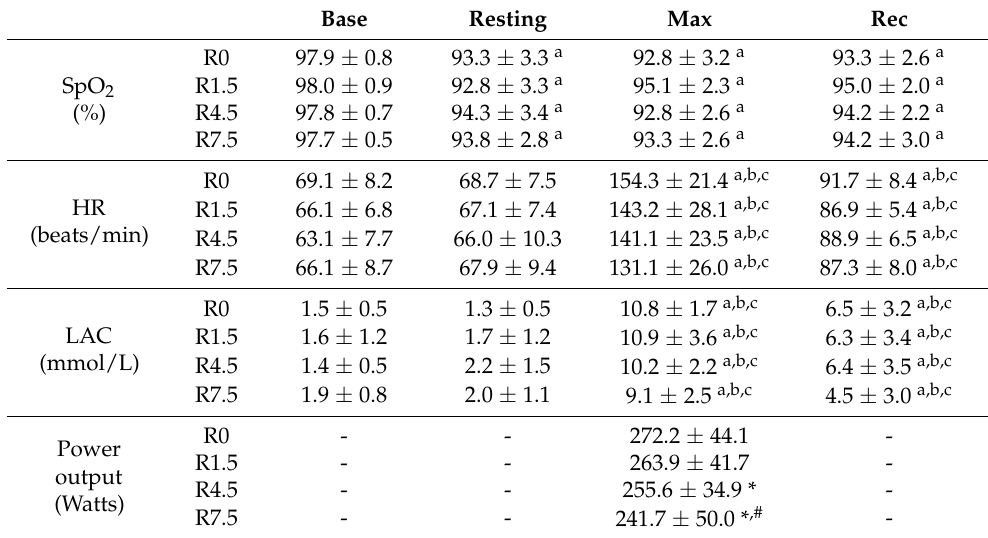
Table 1. Peripheral oxygen saturation (SpO 2 ), heart rate (HR), lactate (LAC), and power output during baseline, resting, maximal exercise, and recovery at four different inspiratory resistance levels. Base